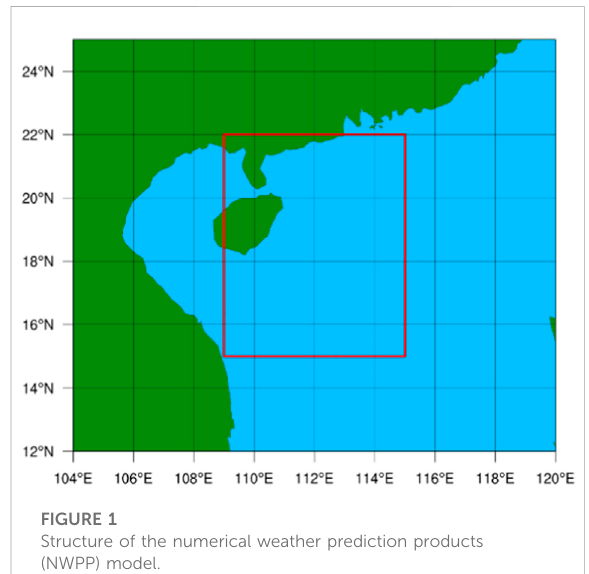
FIGURE 1 Structure of the numerical weather prediction products (NWPP)